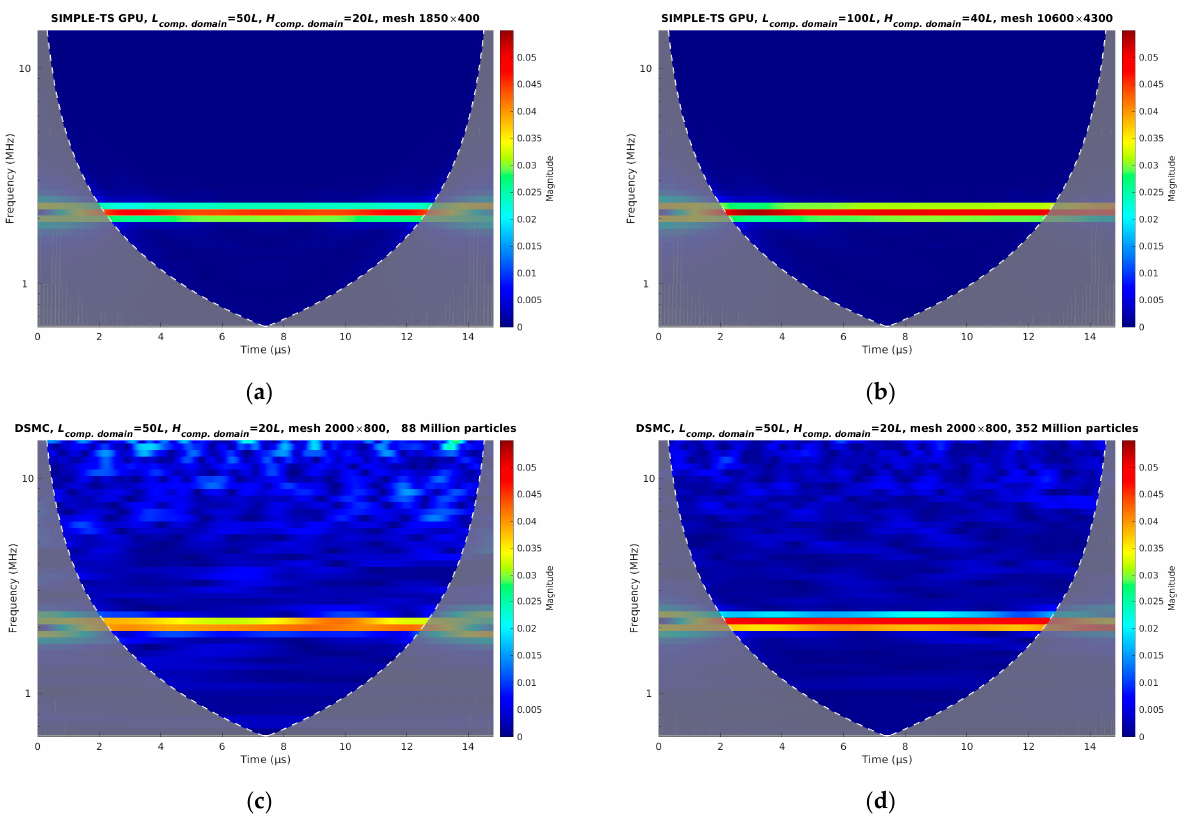
Figure 4. Comparison of continuous 1D wavelet transform with bump wavelet to analyze time series of lift coefficients at established regime obtained by continuum approach (SIMPLE-TS) on compu- tational domain with size ( a ) 50 L × 20 L and mesh with 1850 × 400 cells and ( b ) 100 L × 40 L and mesh with 10,600 × 4300 cells, and DSMC obtained on computational domain with size 50 L × 20 L and ( c ) 88 million particles and ( d ) 352 million particles. Table 1. Comparison of frequencies, amplitudes, and Strouhal numbers of lift coefficients at estab- lished regime obtained by SIMPLE-TS GPU (continuum approach) and DSMC (molecular ap- proach) and analyzed by FFT and CWT.